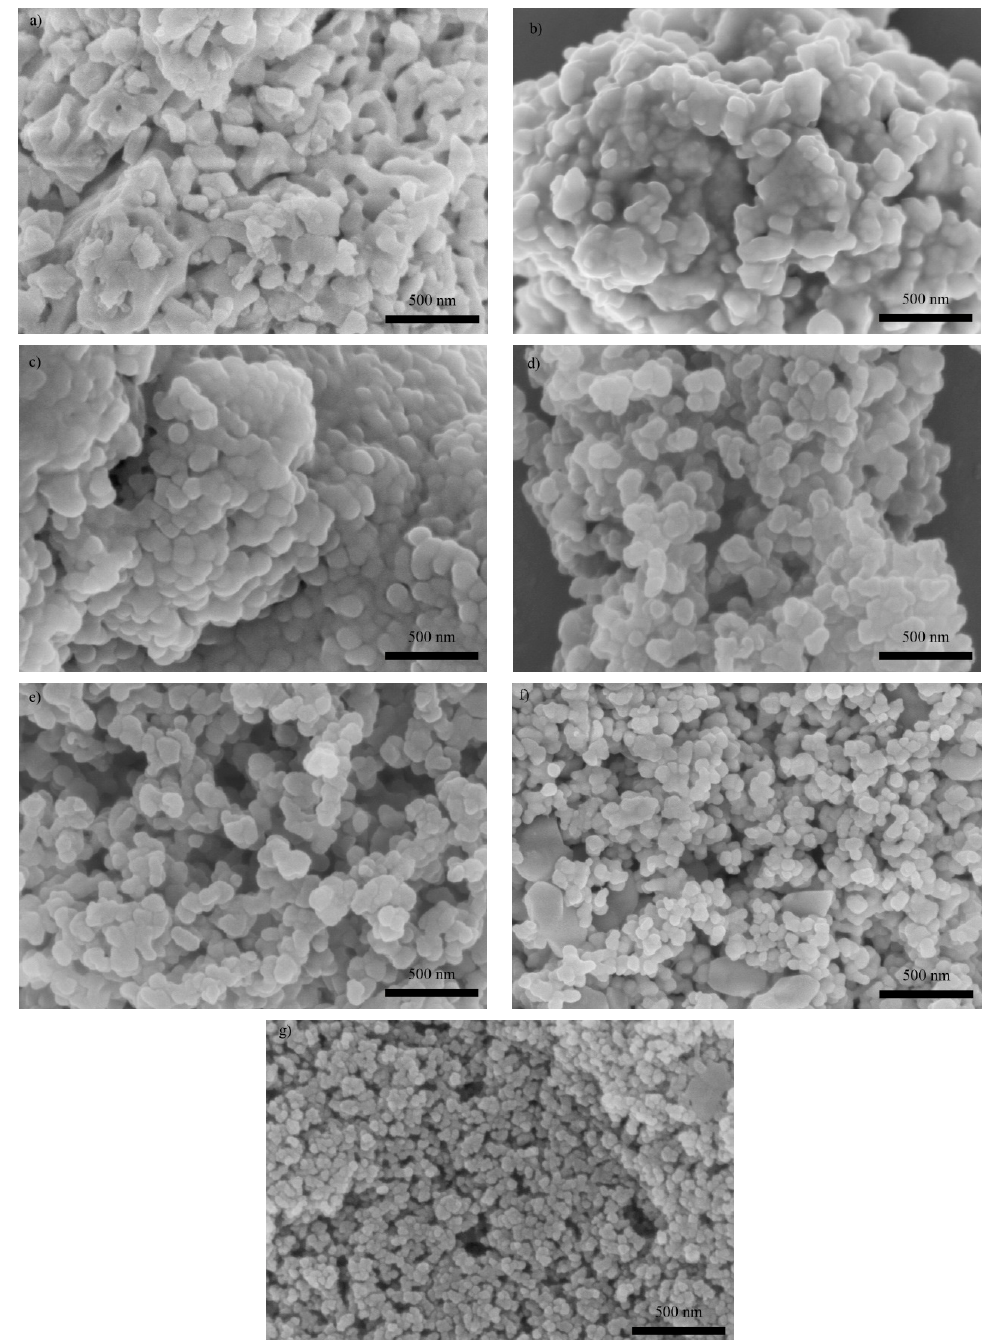
Figure 2. SEM micrographs of as-prepared nanoparticles: ( a ) YFO; ( b ) Co5; ( c ) Gd5; ( d ) Gd5Co5; ( e ) Gd10Co5; ( f ) Gd15Co5; ( g ) Gd20Co5.